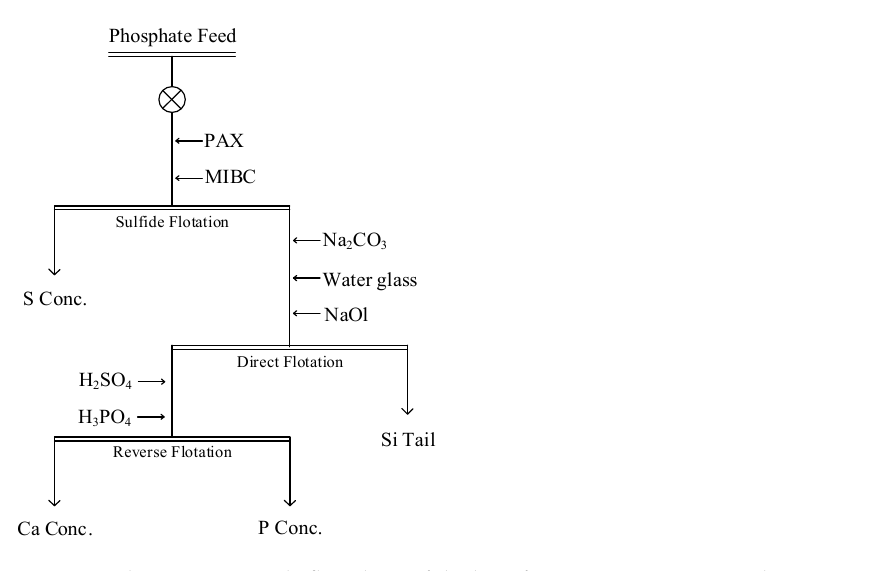
Figure 3. Schematic principle flowsheet of the beneficiation; In some tests, there was an additional cleaning flotation step of the floated phosphate minerals.